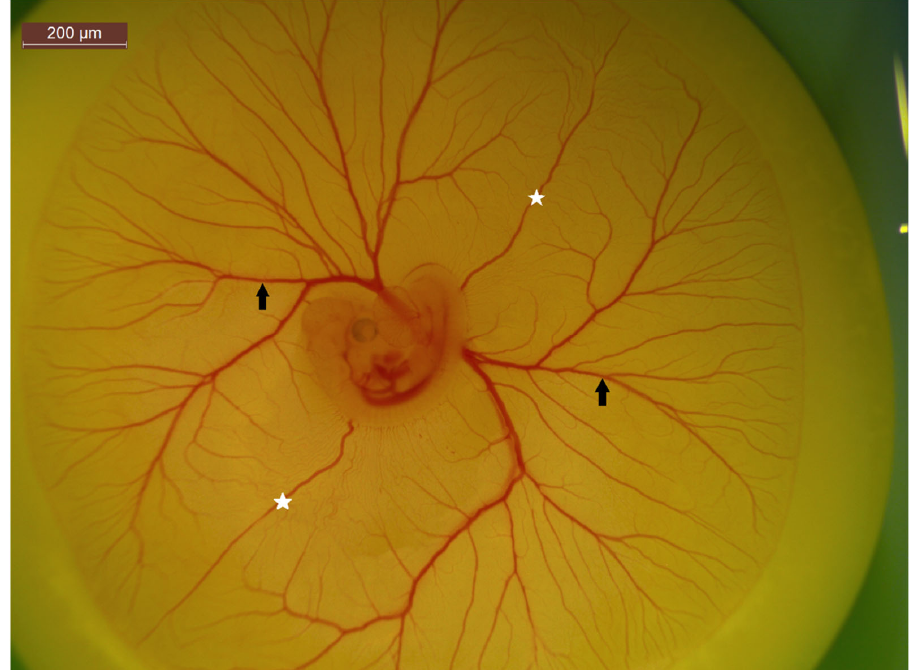
Figure 4. A 5 ‐ day ‐ old chick embryo highlight CAM vasculature. The white stars represent anterior and posterior vitelline veins, while the black arrows indicate vitelline arteries and veins. The non ‐ branching nature of the vitelline veins make it an ideal location for